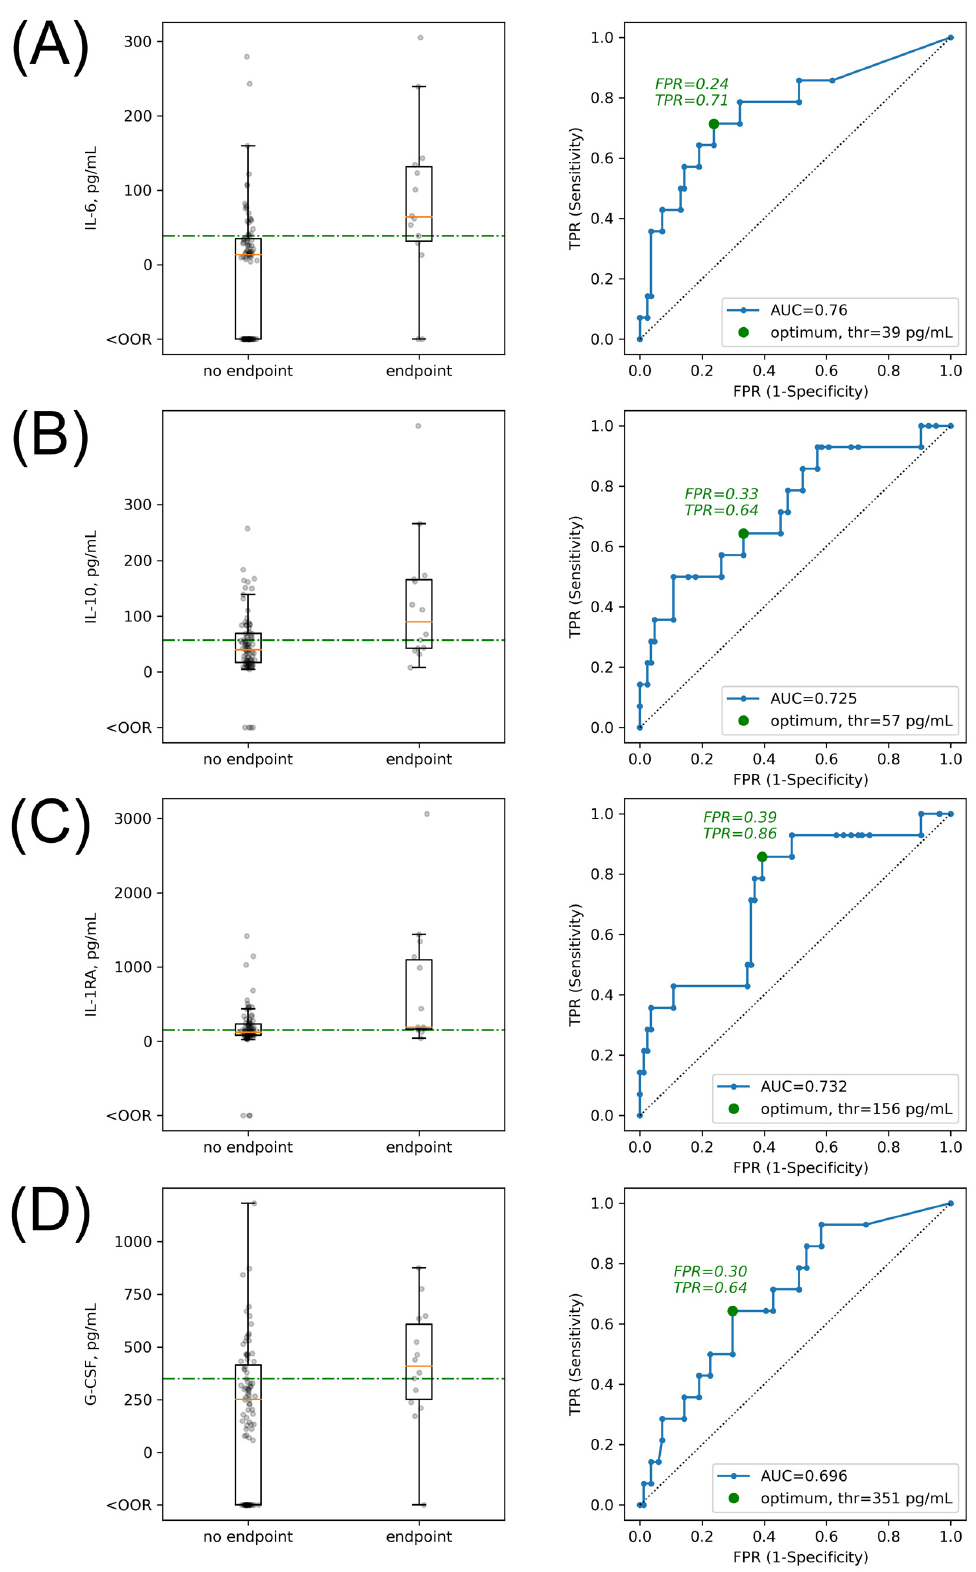
Figure 3. Boxplots for the absolute concentrations and ROC curves for selecting optimal concentration threshold for the 4 cytokines prominently associated with clinical endpoints. IL-6 ( A ). IL-10 ( B ). IL-1RA ( C ). G-CSF ( D ). OOR—out of range (<lower limit of detection).